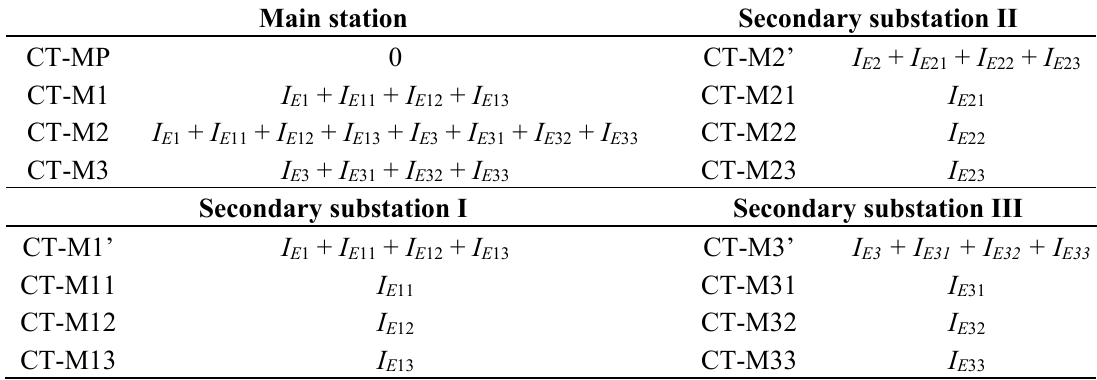
Figure 10. Highest SPGF currents at isolated network with main and secondary substations. Ground fault at Line 2. Table 2. Residual Current Measurements. SPGF at Line 2—Phase “ a ”— rms current value